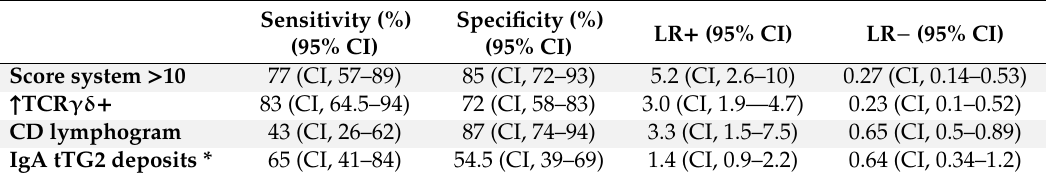
Table 4. The accuracy of a score > 10 as compared to the increase of TCR γδ + IEL, positive CD low-grade coeliac enteropathy diagnosis in seronegative patients ( n = 84 seronegative patients; 30 low-grade coeliac enteropathy vs. 54